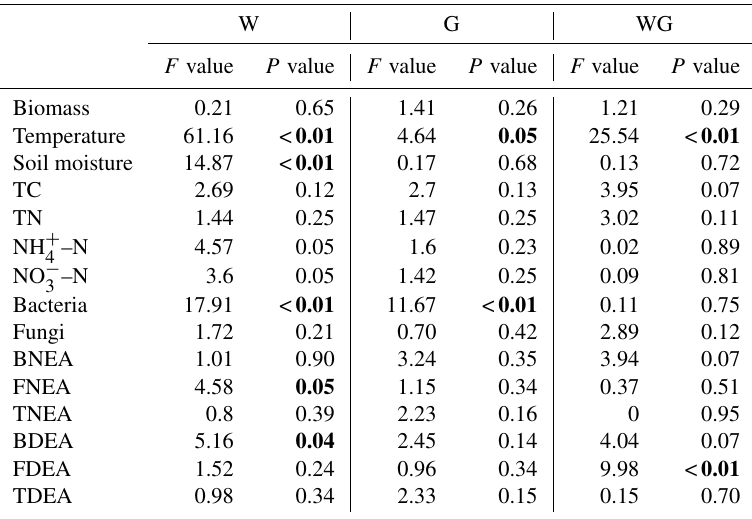
TDEA Bold indicates significance at P